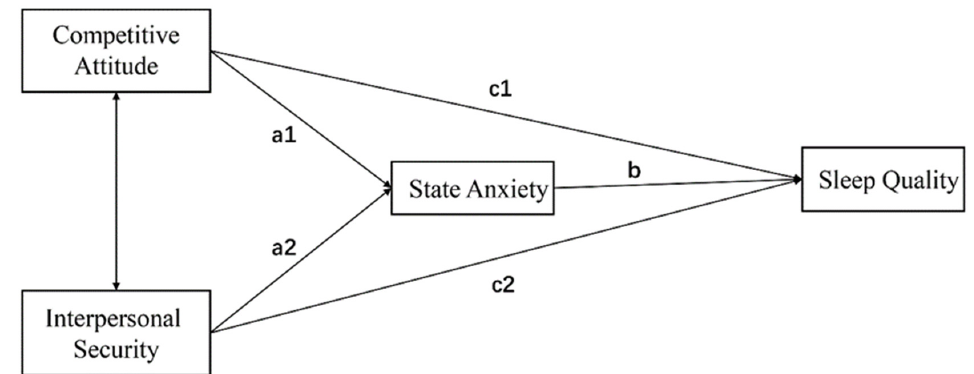
Figure 1. Path analysis model conducted in the current study. Notes: Double-headed arrows represent the association between variables, and single-headed arrows represent prediction routes.